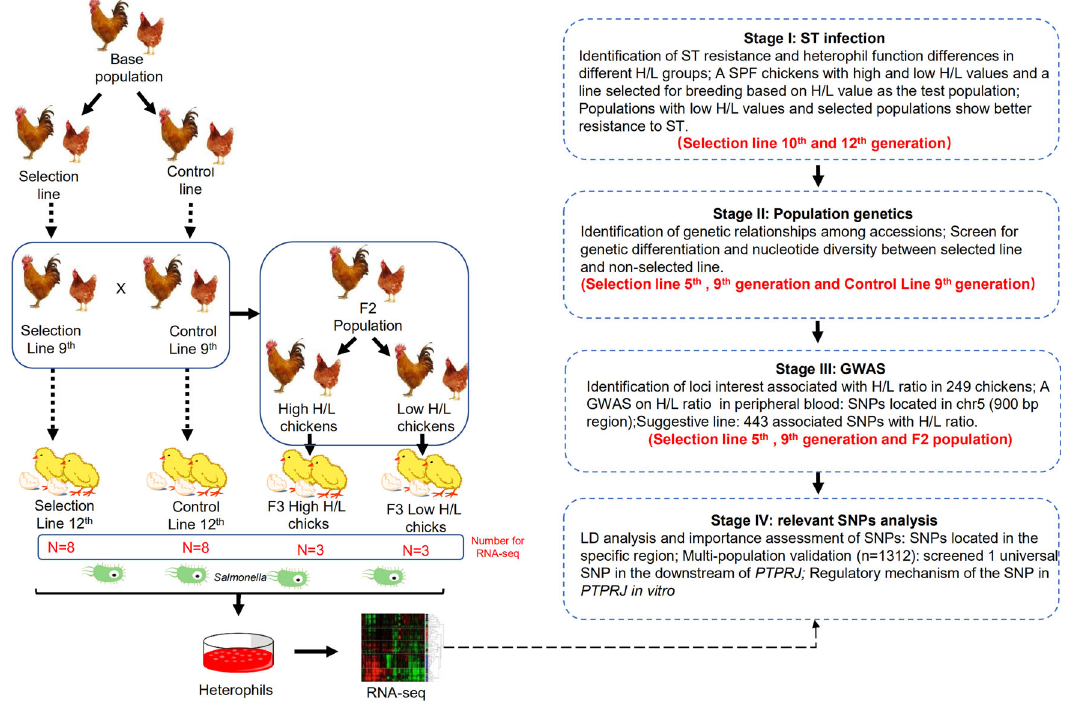
Fig. 1 Graphic representation of study design. ST Salmonella typhimurium, H/L Heterophil to lymphocyte ratio, GWAS Genome-wide association study, SNPs Single nucleotide polymorphisms, LD Linkage disequilibrium (LD), PTPRJ Protein tyrosine phosphatase, receptor type